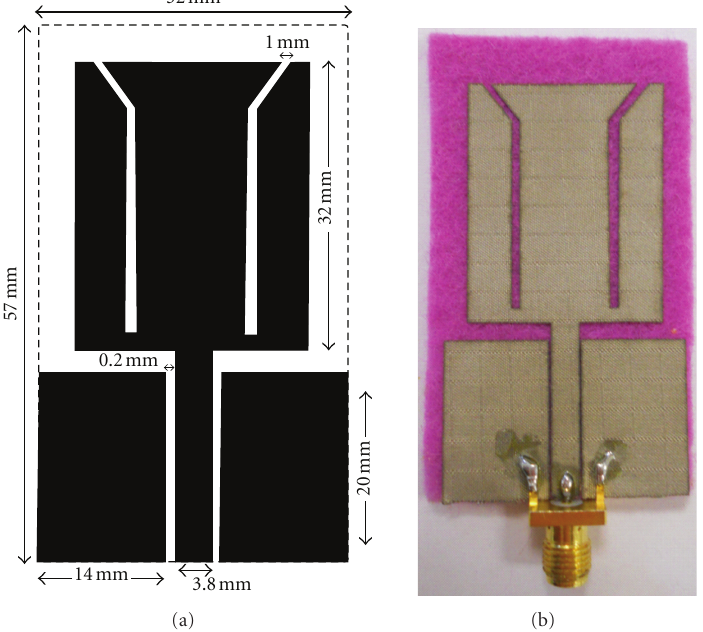
Figure 14: CPW-fed broadband antenna geometry and prototype.